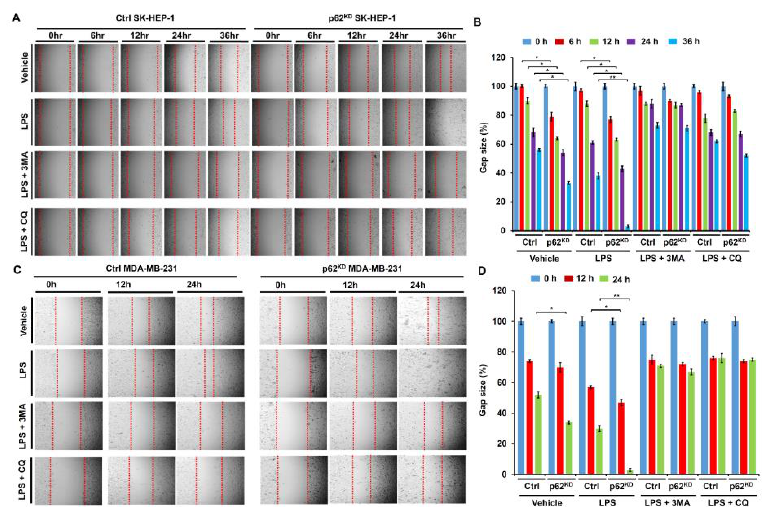
Figure 4. p62 KD SK-HEP-1 and p62 KD MDA-MB-231 cells exhibit increased cell migration in response to TLR4 stimulation. ( A , B ) Ctrl and p62 KD SK-HEP-1 cells were seeded into 12-well cell culture plates. Confluent monolayers were scraped with a sterile yellow Gilson-pipette tip, and the wound was then treated with vehicle (DMSO, < 0.2% in culture medium), LPS (10 µ g / mL), 3-MA (5 mM) plus LPS (10 µ g / mL), and CQ (10 µ M) plus LPS (10 µ g / mL) for di ff erent time periods, as indicated. A representative experiment is shown ( A ). The residual gap between the migrating cells from the opposing wound edge was expressed as a percentage of the initial scraped area ( ± SEM, n = 3) ( B ). *, p < 0.05 and **, p < 0.01. ( C , D ) Ctrl and p62 KD MDA-MB-231 were seeded into 12-well cell culture plates. Confluent monolayers were scraped with a sterile yellow Gilson-pipette tip, and the wound was then treated with vehicle (DMSO, < 0.2% in culture medium), LPS (10 µ g / mL), 3-MA (5 mM) plus LPS (10 µ g / mL), and CQ (10 µ M) plus LPS (10 µ g / mL) for di ff erent time periods, as indicated. A representative experiment is shown ( C ). The residual gap between the migrating cells from the opposing wound edge was expressed as a percentage of the initial scraped area ( ± SEM, n = 3) ( D ). * p < 0.05 and ** p < 0.01.